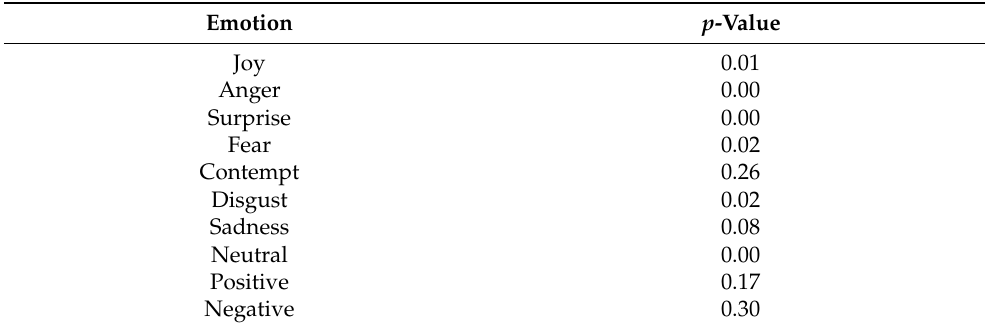
Table 10. p -values of the percentage of observable time for each emotion of H a 1 . Note: p -values were truncated to two decimal places.